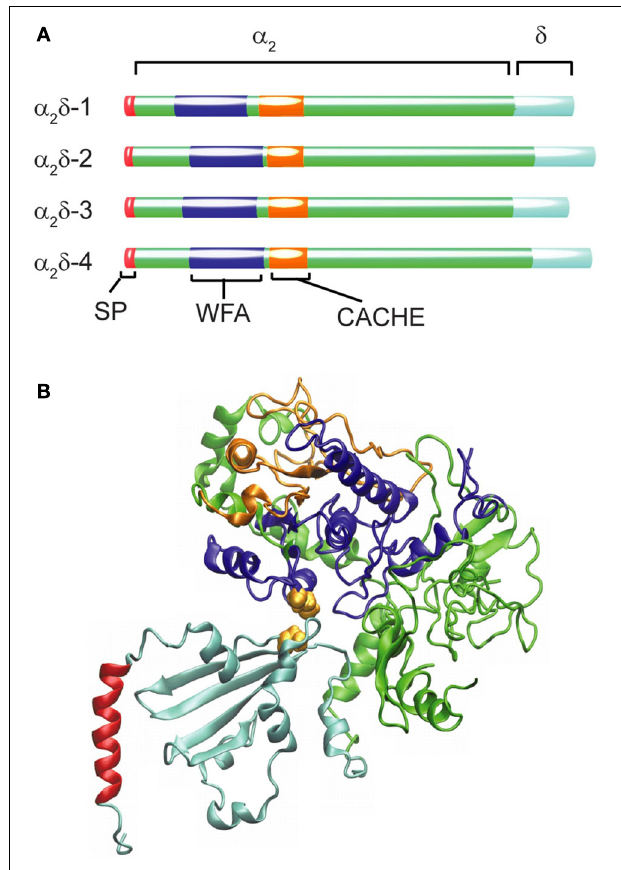
FIGURE 2 | Structural organization and diversity of calcium channel α 2 δ subunits. (A) Schematic representation of the domain arrangement of the four α 2 δ isoforms identified in humans scaled according to the number of amino acids ( α 2 δ -1 acc. · P54289 ; α 2 δ -2 acc. Q9NY47 ; α 2 δ -3 acc. Q8IZS8 ; α 2 δ -4 acc. Q7Z3S7). The N-terminal signal peptide (SP) ranging from 19 amino acids for ( α 2 δ -2) to 29 residues for α 2 δ -3 shown in red is not present in the mature protein. The blue segment depicts the WFA domain and the orange one the CACHE domain. (B) Ribbon diagram of the model proposed by Calderon-Rivera et al. (2012) showing the WFA domain in blue and CACHE in orange while the rest of the α 2 peptide is depicted in green. Within the δ peptide (cyan) an alpha helical segment (shown in red) is likely to represent a membrane-anchoring domain. The cysteine residues required for the α 2 δ assembly are represented as van der Waals surfaces in